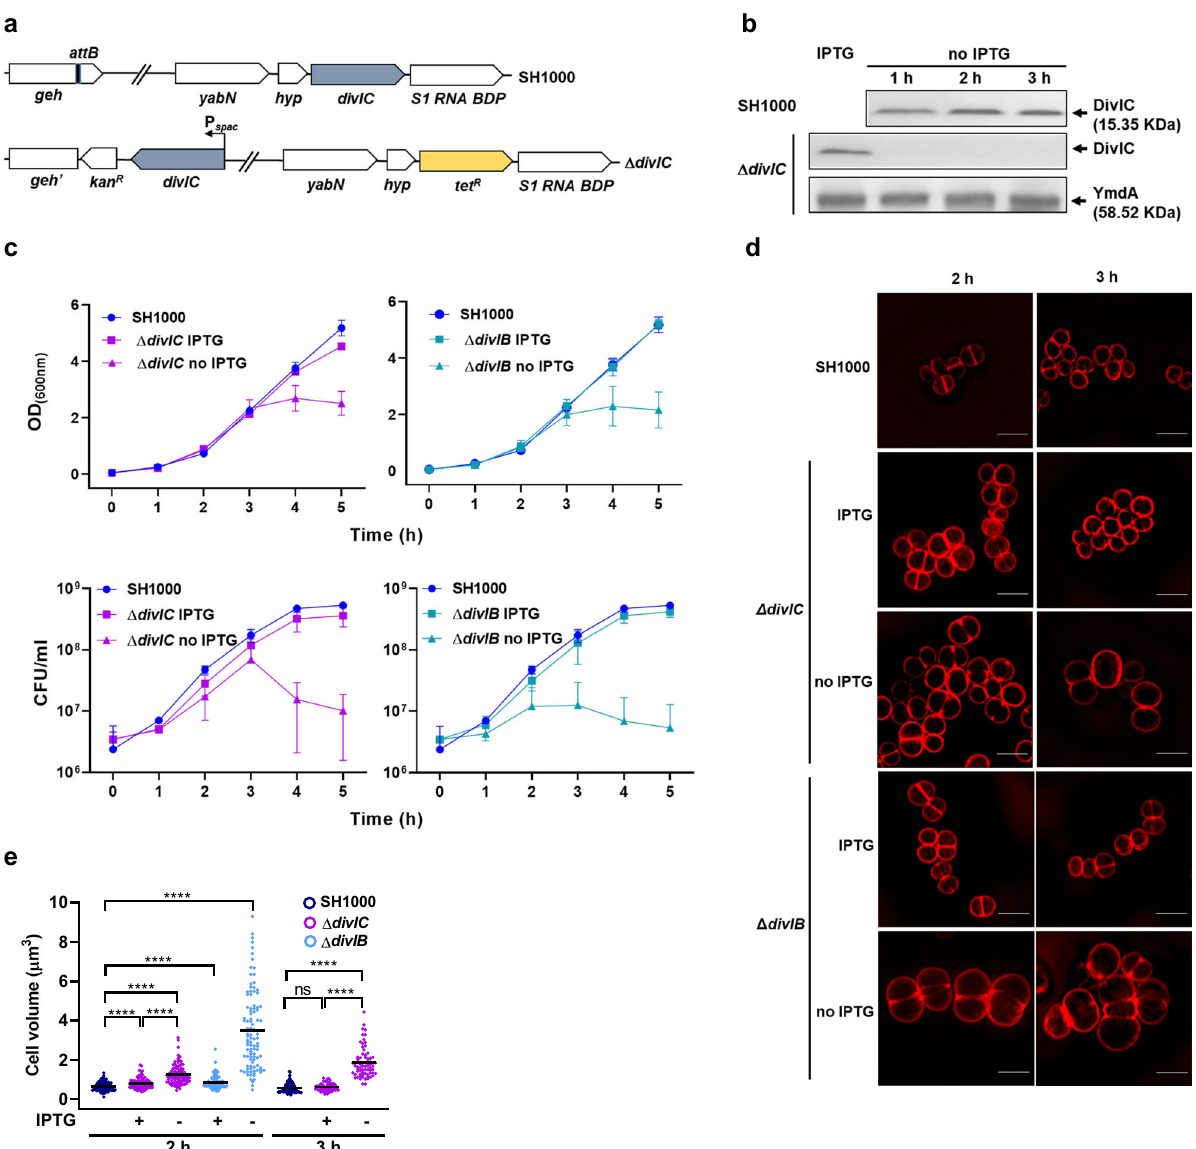
Fig. 1 DivIC is essential for growth, viability and cell size regulation. a Genetic map of the parental (SH1000) and the divIC conditional lethal ( Δ divIC , SJF5450) strains. b Western blot showing levels of DivIC (15.35 KDa) in SH1000, Δ divIC in the presence of IPTG or after 1, 2 and 3 h incubation in the absence of IPTG. Anti-DivIC antibodies were used for detection. Levels of YmdA were detected using anti-YmdA as loading control. c Cell growth (top) and viability (bottom) of SH1000, Δ divIC and Δ divIB (SJF3883) strains in the presence and absence of IPTG. Graphs show mean and standard deviations of three independent experiments. d Structured Illumination Microscopy (SIM) images of SH1000, Δ divIC and Δ divIB cells grown for 2 and 3 h with and without IPTG and treated with NHS-ester 555 to stain cell walls. Images are average intensity projections of z stacks. Scale bars, 2 μ m. Data is representative of two independent experiments. e Cell volumes of SH1000, Δ divIC and Δ divIB cells grown with and without IPTG for 2 and 3 h (SH1000 and Δ divIC only), determined from SIM images of cells stained with NHS-ester 555. Each circle indicates a single cell. n = 100 cells for samples taken a 2 h and SH1000 at 3 h, n = 62 and 63 for 3 h plus and minus IPTG respectively. P -values were determined by Mann – Whitney U -tests (**** P < in cultures grown with IPTG accounted for ~30% of the total, reached the stage of septal completion (~4%) or showed signs of HADA allowed the identi fi cation of cells with no septum, an cell splitting (~1%), (Fig. 2d left). Next, the role of DivIC in the incomplete septum, or a complete septum, while ADA-DA signal progression of the population of cells identi fi ed as with an indicated the progression into subsequent stages of the cell cycle incomplete septum (by HADA labelling) was analysed (Fig. 2d (Fig. 2d). In the absence of DivIC, ~10% of the cells identi fi ed by centre). Only ~37% of the total, of the DivIC depleted cells, had HADA labelling as originally with no septum failed to progress reached the splitting stage after septation (by ADA-DA labelling) into the next stages of cell division (compared to only ~1% in cells compared to ~84% for SH1000 (Fig. 2d centre), indicating a delay expressing the protein). An accumulation of cells with an in septal development. The Δ divIC cells grown with IPTG also incomplete septum (~14% more of the total compared to control showed a delay to transit from incomplete septum to separation cells) was also observed. Only a small proportion of cells, which (~54%) (Fig. 2d centre).